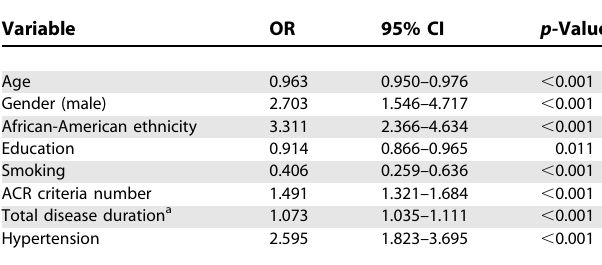
Table 4. Variables Independently Associated with the Occur- rence of Renal Involvement at Any Time during the Course of SLE in PROFILE